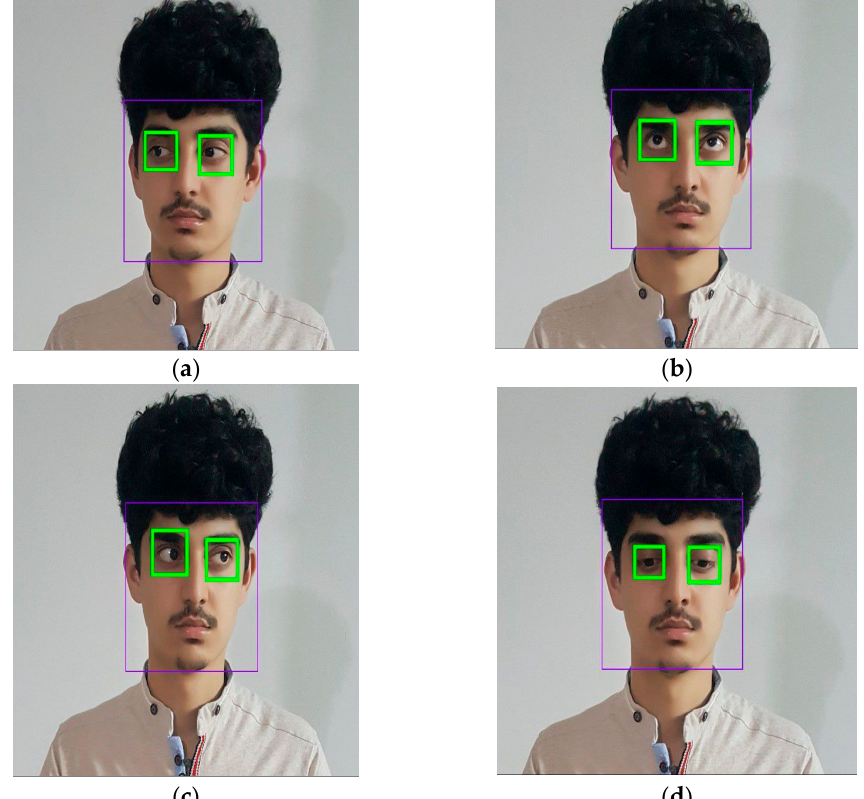
Figure 3. Gaze avoidance. ( a ) Looking left, ( b ) looking above, ( c ) looking right, ( d ) looking